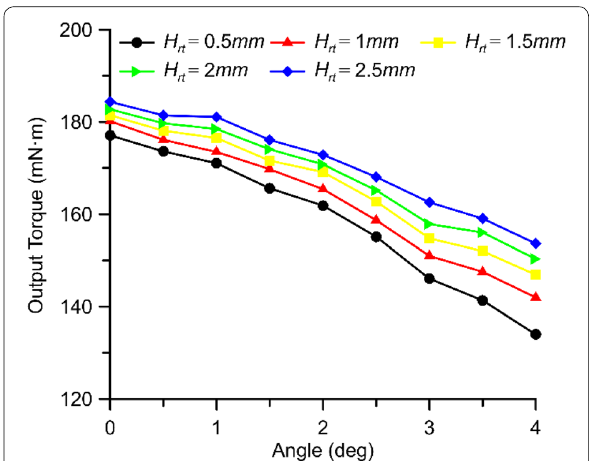
Figure 9 Effect of H rt on torque–angle characteristics